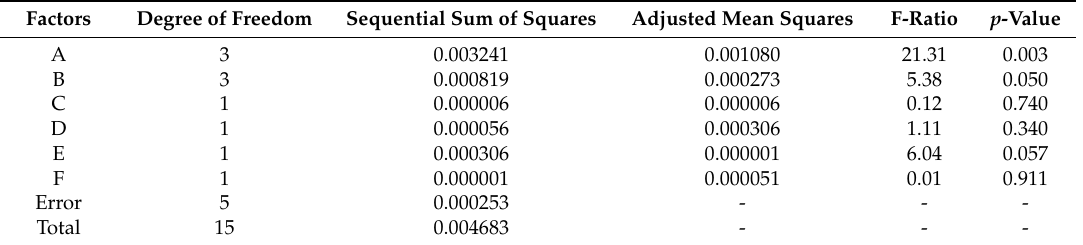
Table 3. Analysis of variance (ANOVA) for the S/N ratios of the machining surface roughness.